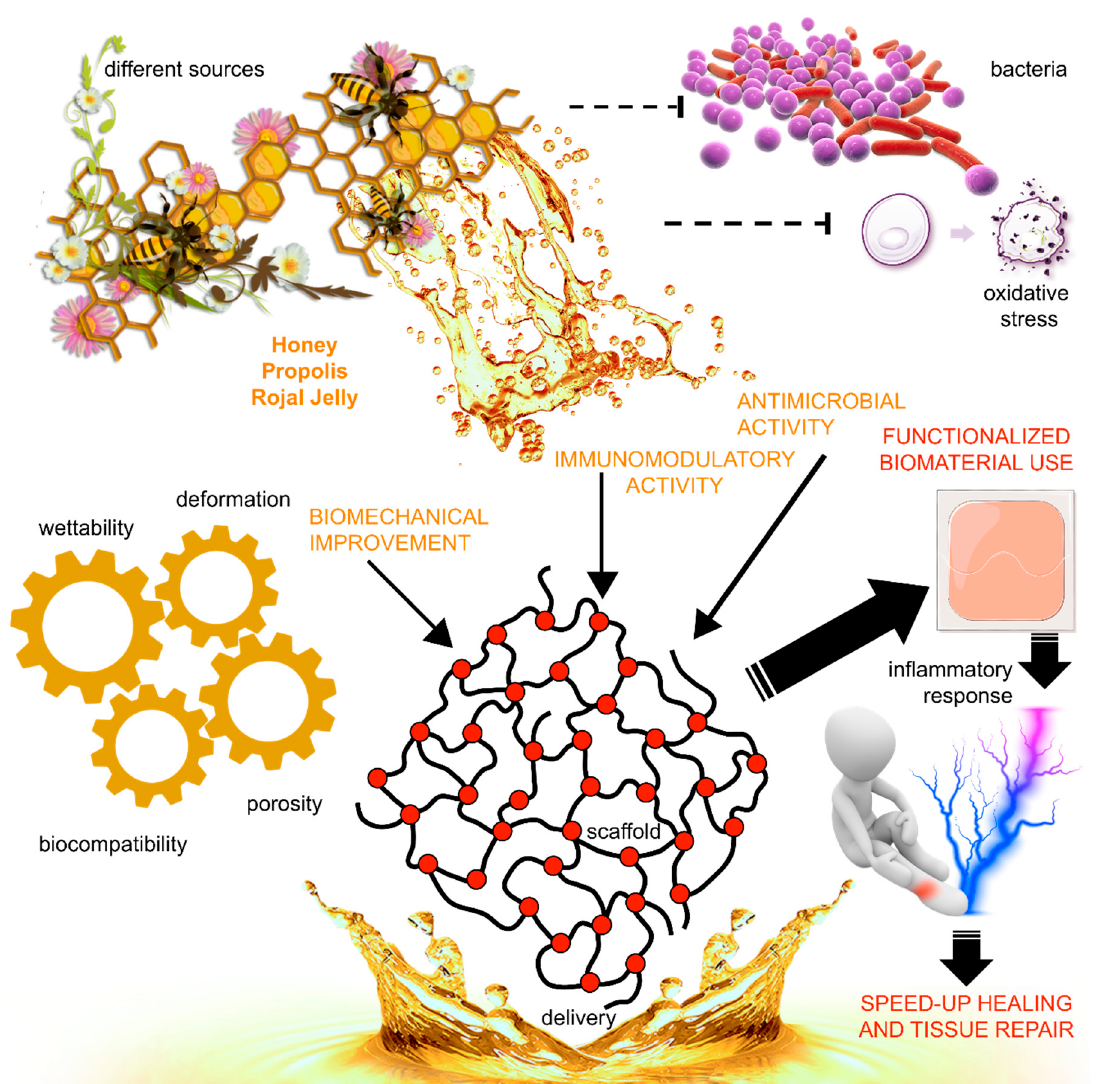
Figure 1. Overview of the advantages of using honeybee products in tissue engineering. Honeybee products, such as honey, propolis, and royal jelly, differ according to the botanical source and the geographical origin. Importantly, they share bioactive compounds with significant antimicrobial, antioxidant, and immunomodulatory effects, suitable for modifying functional properties of biomaterials. These features can be transferred to a scaffold for biomedical application in order to adapt its mechanical properties, to avoid its rapid degradation, bacterial infection, and cell toxicity, and to allow a local delivery. The application or the transplantation in the body of the scaffold functionalized by honeybee products can favor the healing and the repair of injured tissues, by indirectly modulating the inflammatory response.